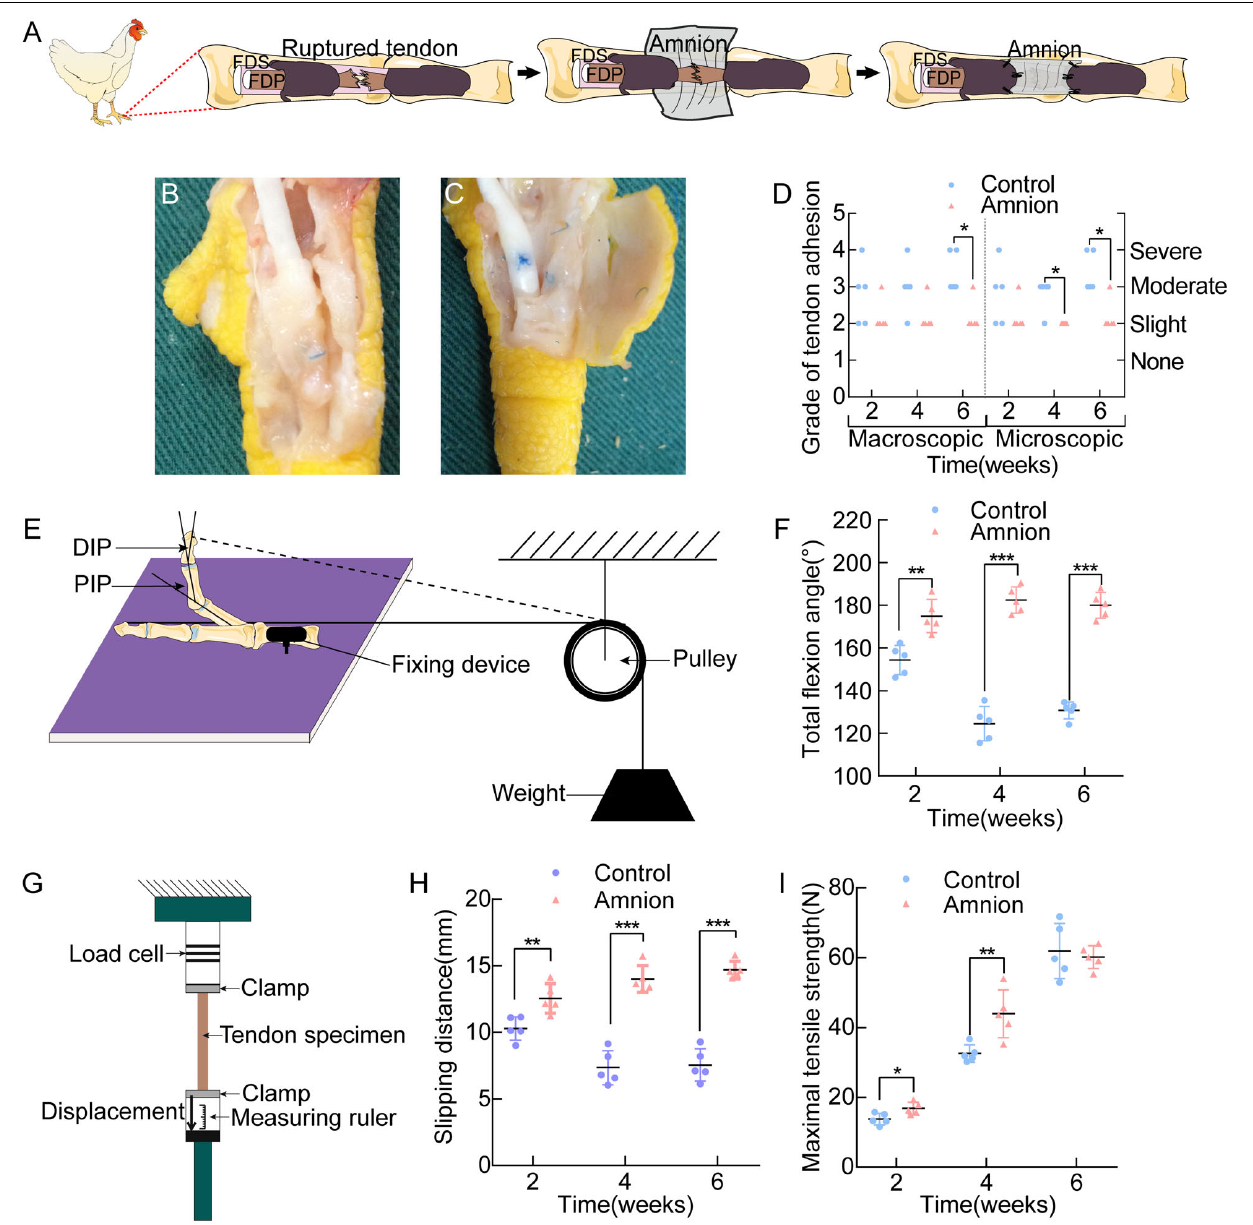
FIGURE 5 | (A) Operative technique for the application of the acellular amnion allograft. Establishment of flexor digitorum profundus tendon model in chickens. The tendon has been sutured, and the membrane is placed between the flexor tendons. The membrane is wrapped around the FDP tendon and fixed to the remaining tendon sheath. General observation of the control group (B) and amnion group (C) on the 4th week after the operation. (D) The macroscopic and microscopic evaluation of adhesion on the 2nd, 4th, and 6th week after the operation. Scheme of the total flexion angle measurement (E) and the results of the total flexion angle (F) . Scheme of the sliding distance, the maximal tensile strength (G) and the results of the sliding distance (H) , the maximal tensile strength (I) between the two groups on the 2nd, 4th, and 6th week after the operation. * p < 0.05; ** p < 0.01; and *** p <